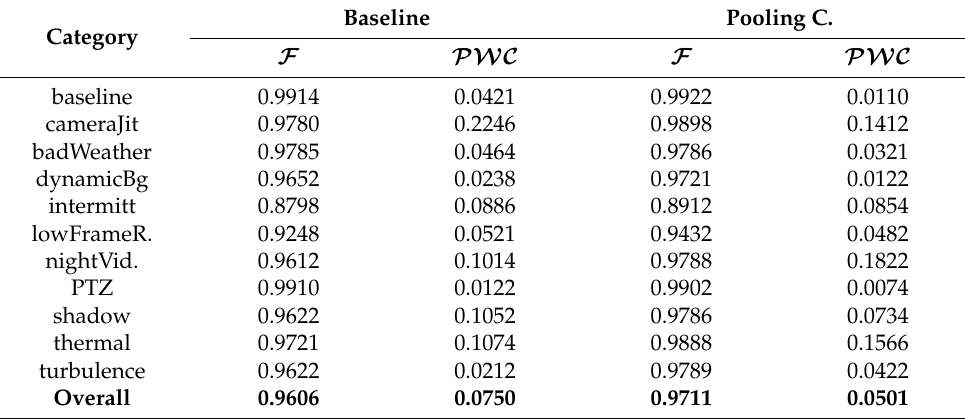
Figure 4. Qualitative comparison results of pooling compensation ablation study. Table 7. Accuracy comparison results of pooling compensation mechanism. The last row represents the average result for each scenario.